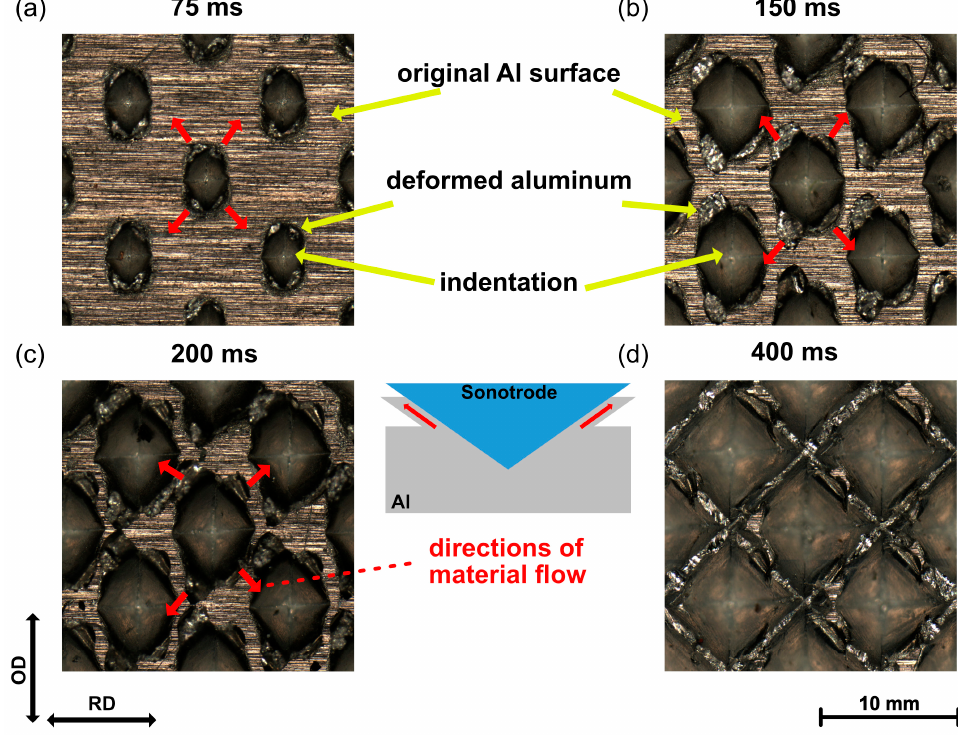
Figure 2. Indentation on the Al surface at different weld times: ( a ) 75 ms; ( b ) 150 ms; ( c ) 200 ms; ( d ) 400 ms, with u = 28 µ m, and F us = 700